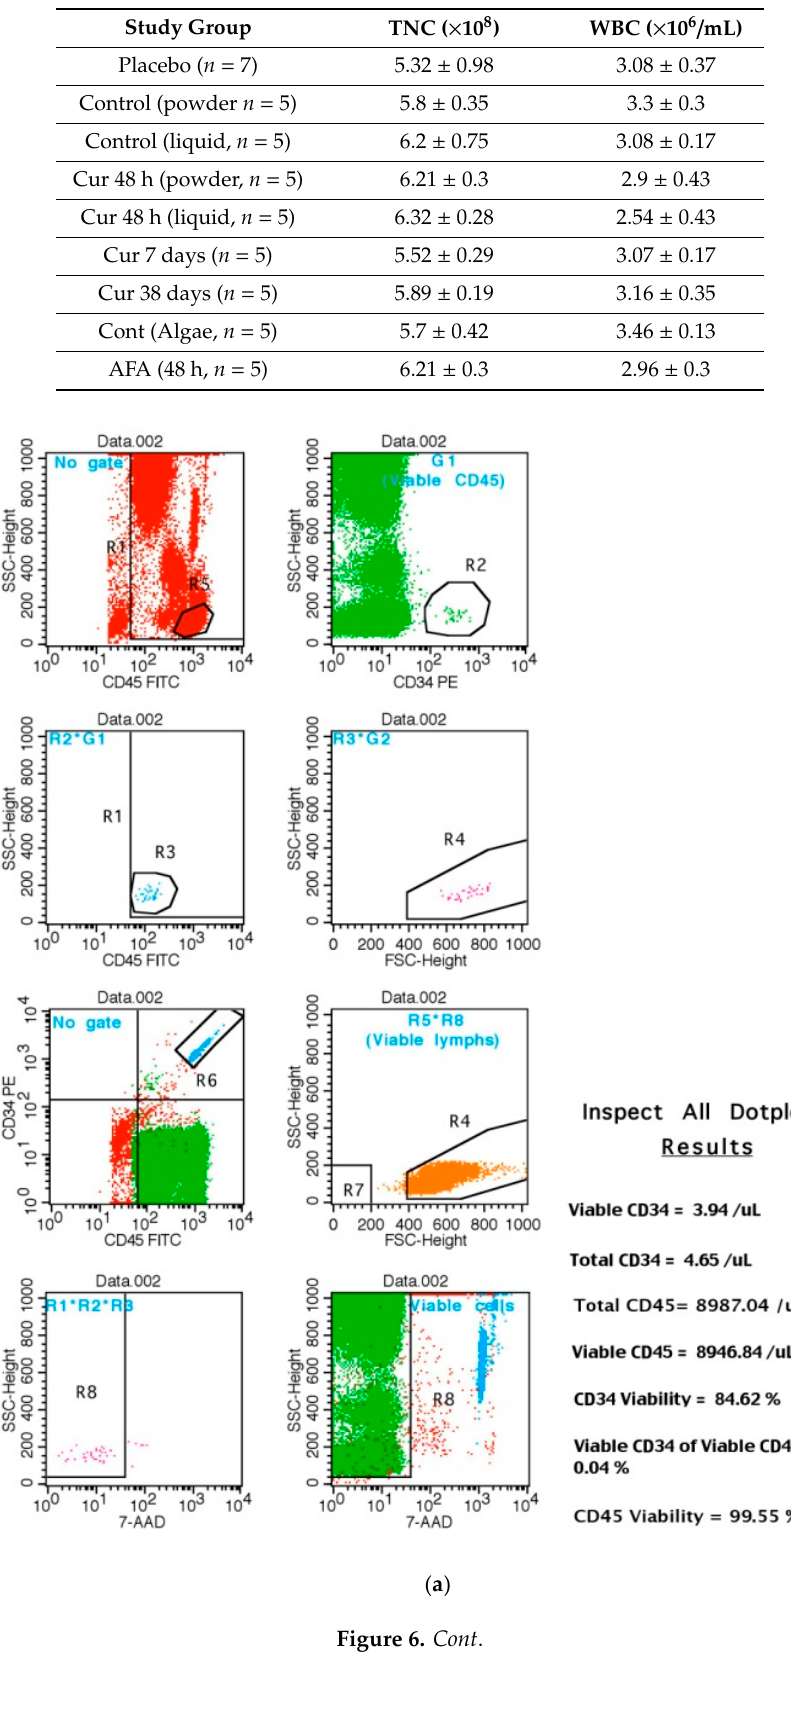
Table 3. Absence of di ff erences for TNC or WBC levels in healthy patients.